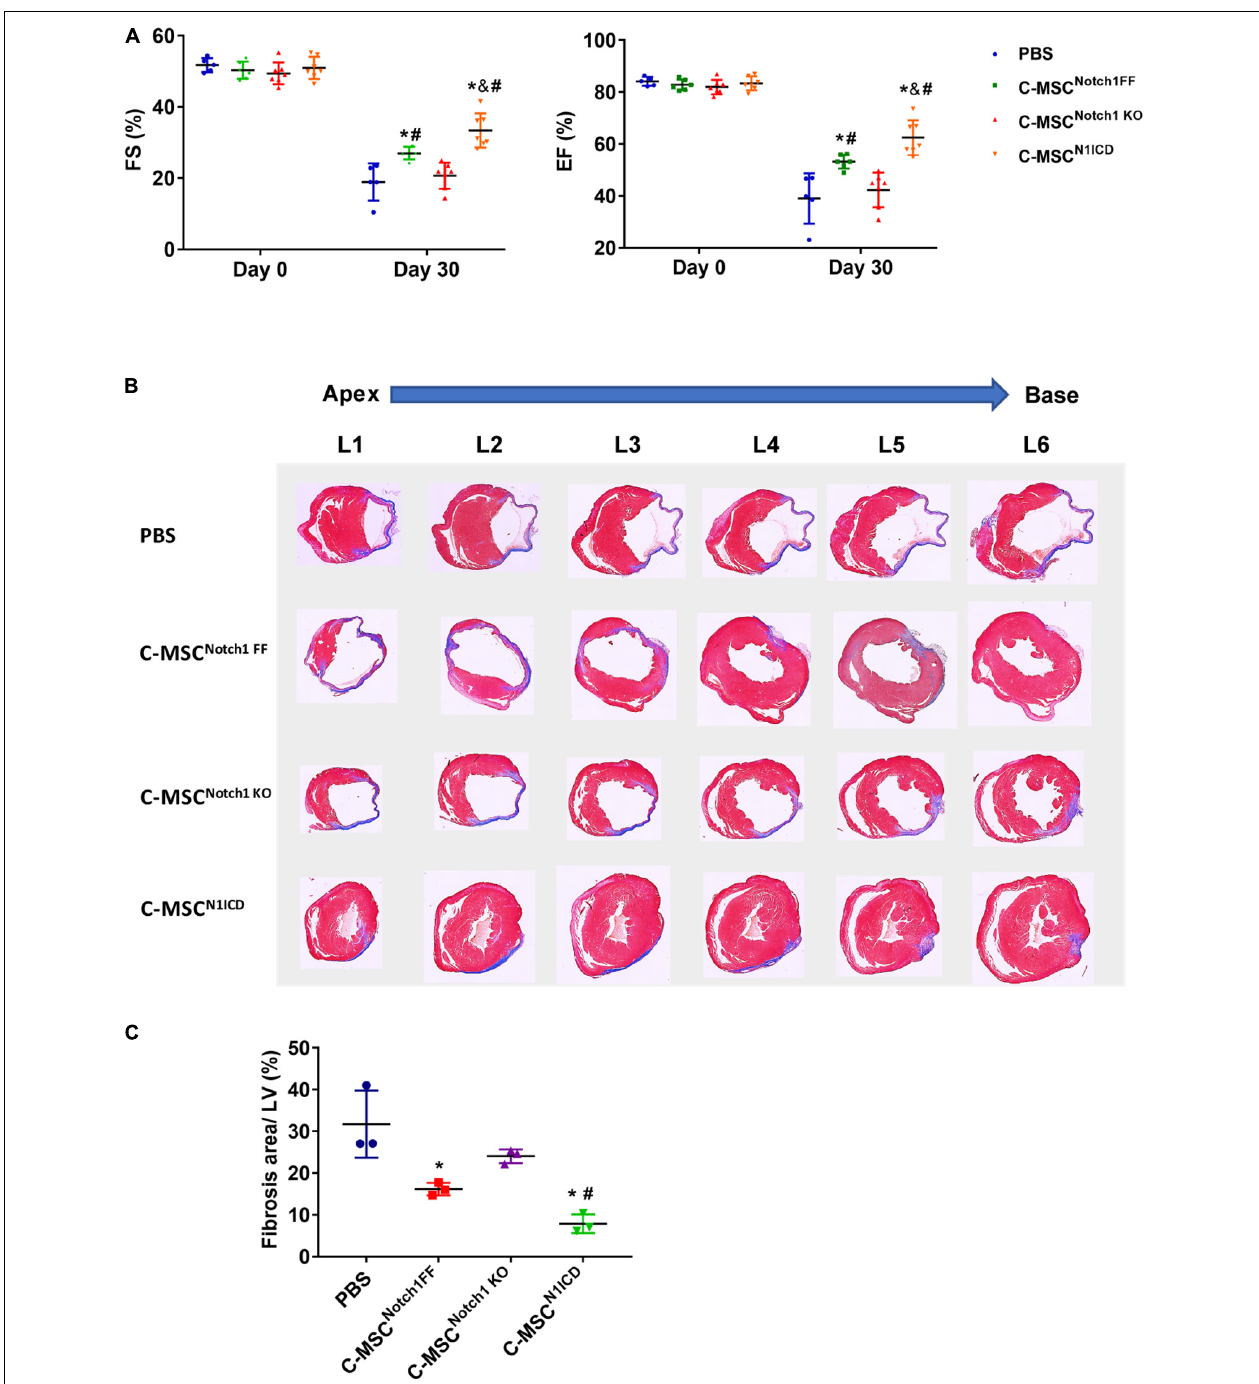
FIGURE 1 | Notch1 intracellular domain (N1ICD)-overexpressing cardiac mesenchymal stem cells (C-MSC) (C-MSC N1ICD ) transplantation improved cardiac function and attenuated cardiac fibrosis after myocardial infarction (MI). (A) Intramyocardium transplantation of both C-MSCs Notch1FF and C-MSCs N1ICD improved fractional shortening (FS) and ejection fraction (EF) compared with PBS-treated mice ( P < 0.001). n = 5 in PBS, n = 7 C-MSC Notch1KO and Exo-C-MSC N1ICD groups; n = 6 in C-MSC Notch1FF group. (B) Representative Masson trichrome-stained sections of hearts from mice treated with C-MSC Notch1FF , C-MSC Notch1KO , and C-MSC N1ICD 1 month after MI. (C) Quantitative analysis of fibrosis size from different treated mice 1 month after MI C-MSCs N1ICD significantly decreased fibrosis size compared with other groups, respectively ( n = 3). * vs. PBS group, # vs. C-MSC Notch1KO group, & vs. C-MSC Notch1FF , P < 0.01.